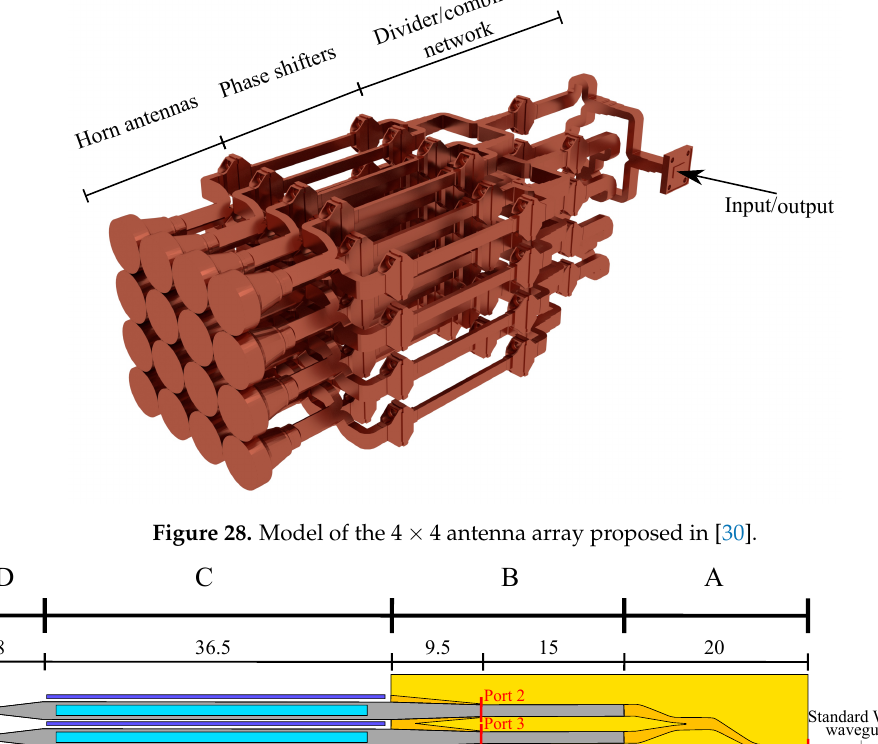
4 antenna array proposed in [30]. ×